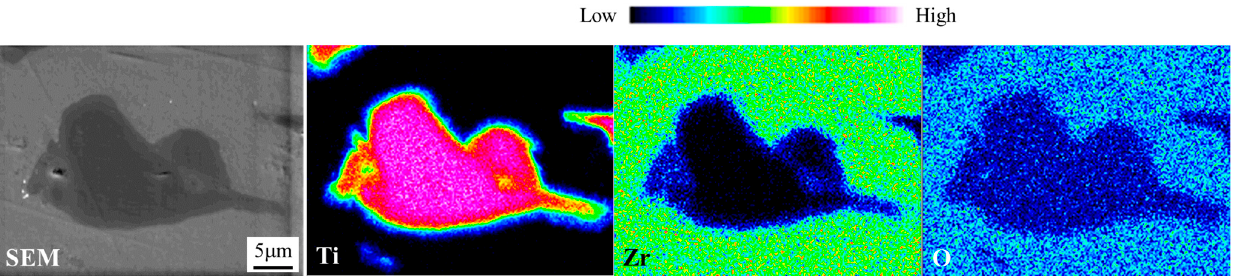
Figure 1. Element distributions of Zr, Ti, and O in PSZ ‐ Ti composite fabricated via SPS.